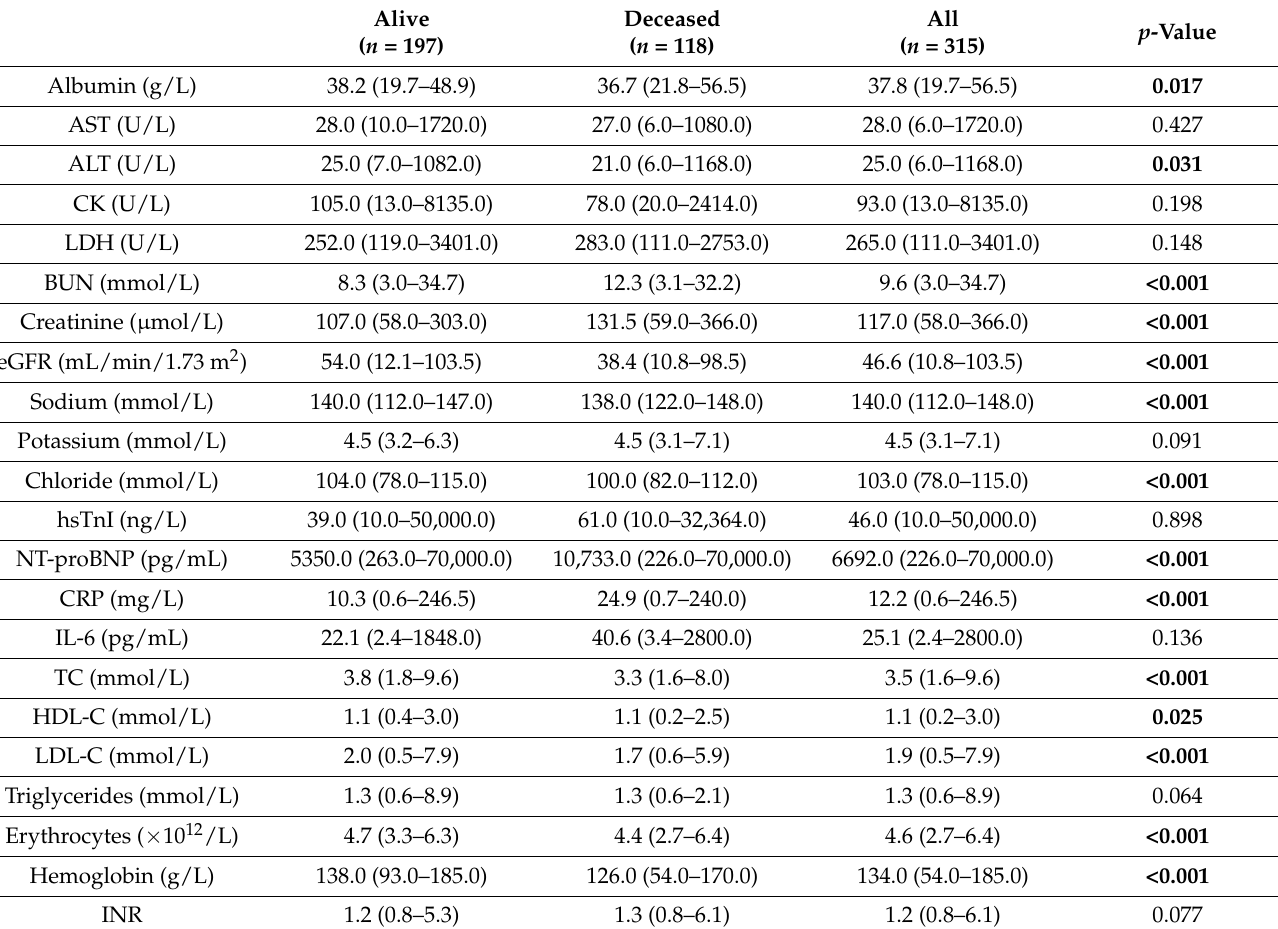
Table 2. Laboratory data of AHF patients upon hospital